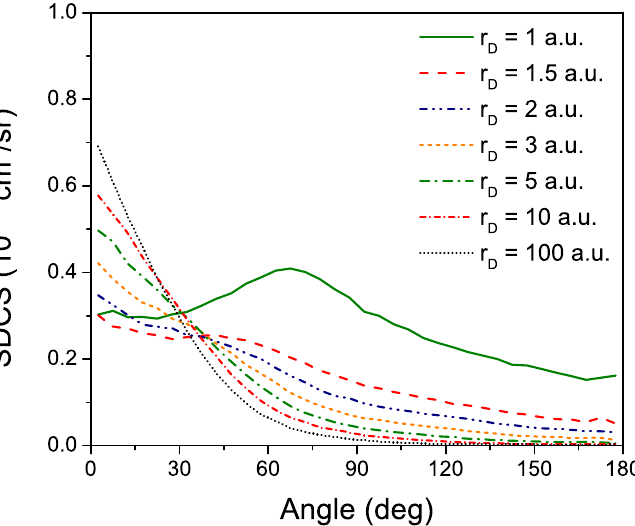
Figure 2. The CTMC singly differential cross section as a function of the electron emission angle for different r D